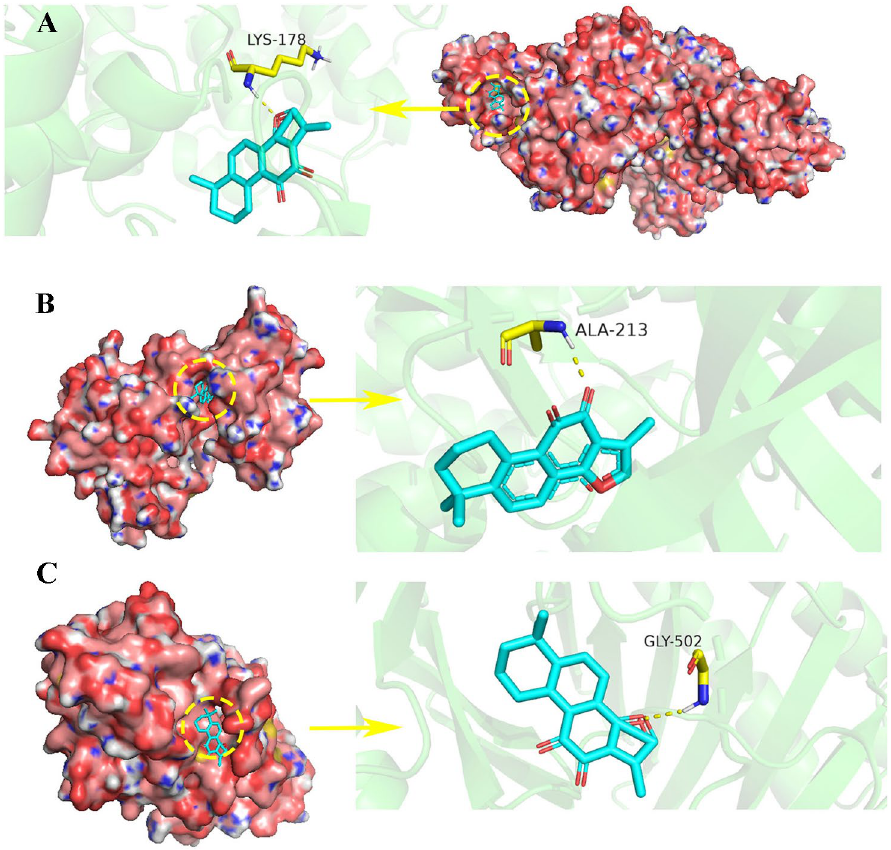
Figure 5. The molecular docking between TSA and corresponding target. ( A ) CCNA2-CDK2 complex-TSA. ( B ) AURKA-TSA. (C)